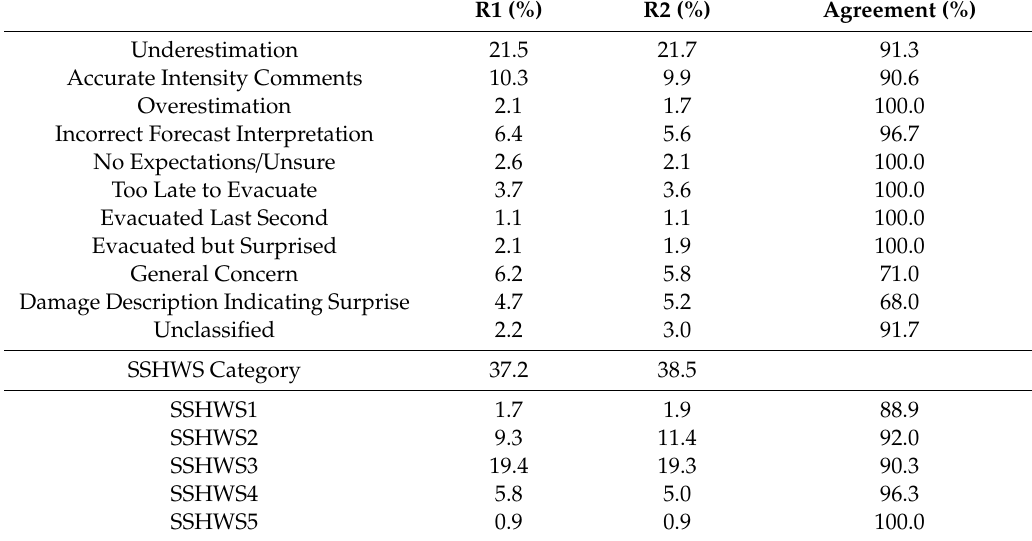
Table 2. Responses to question 25, “What were your expectations of the strength of Hurricane Michael?” Responses were organized into 12 themes and percentages were calculated by 2 raters (R1 and R2). The agreement column indicates the percentage of comments for each theme that were labeled by both